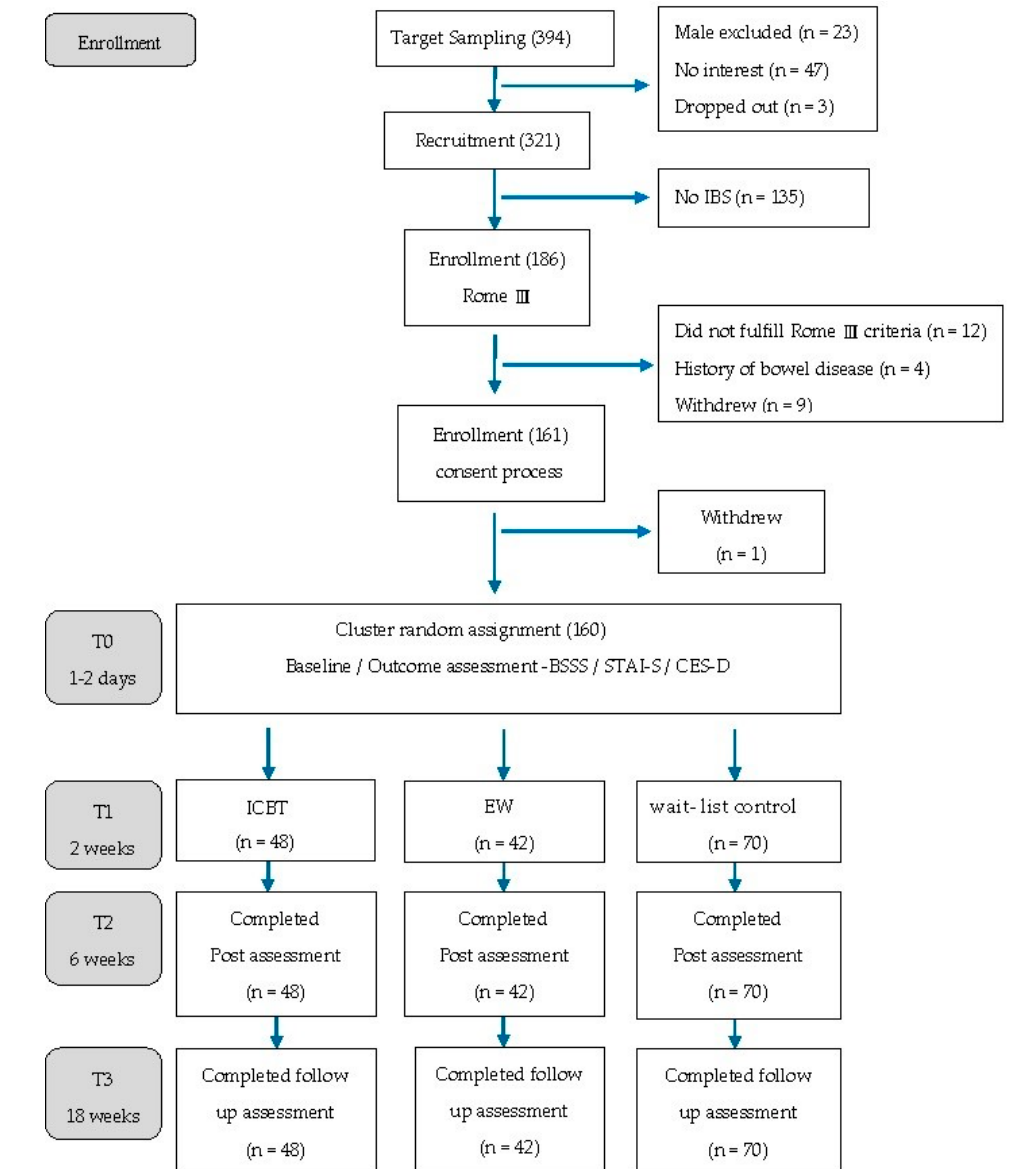
Figure 1. Study Flowchart.